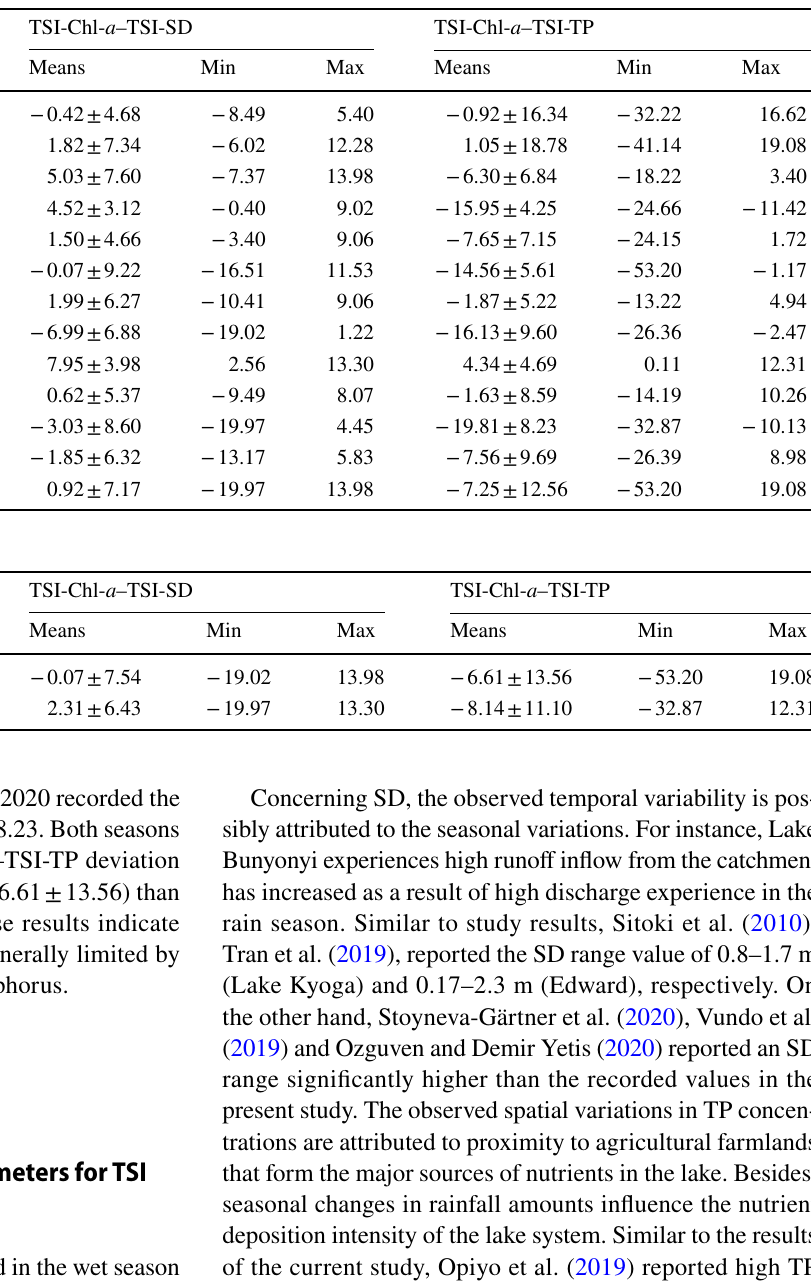
deviation and range of the TSI deviations ( n = 108)